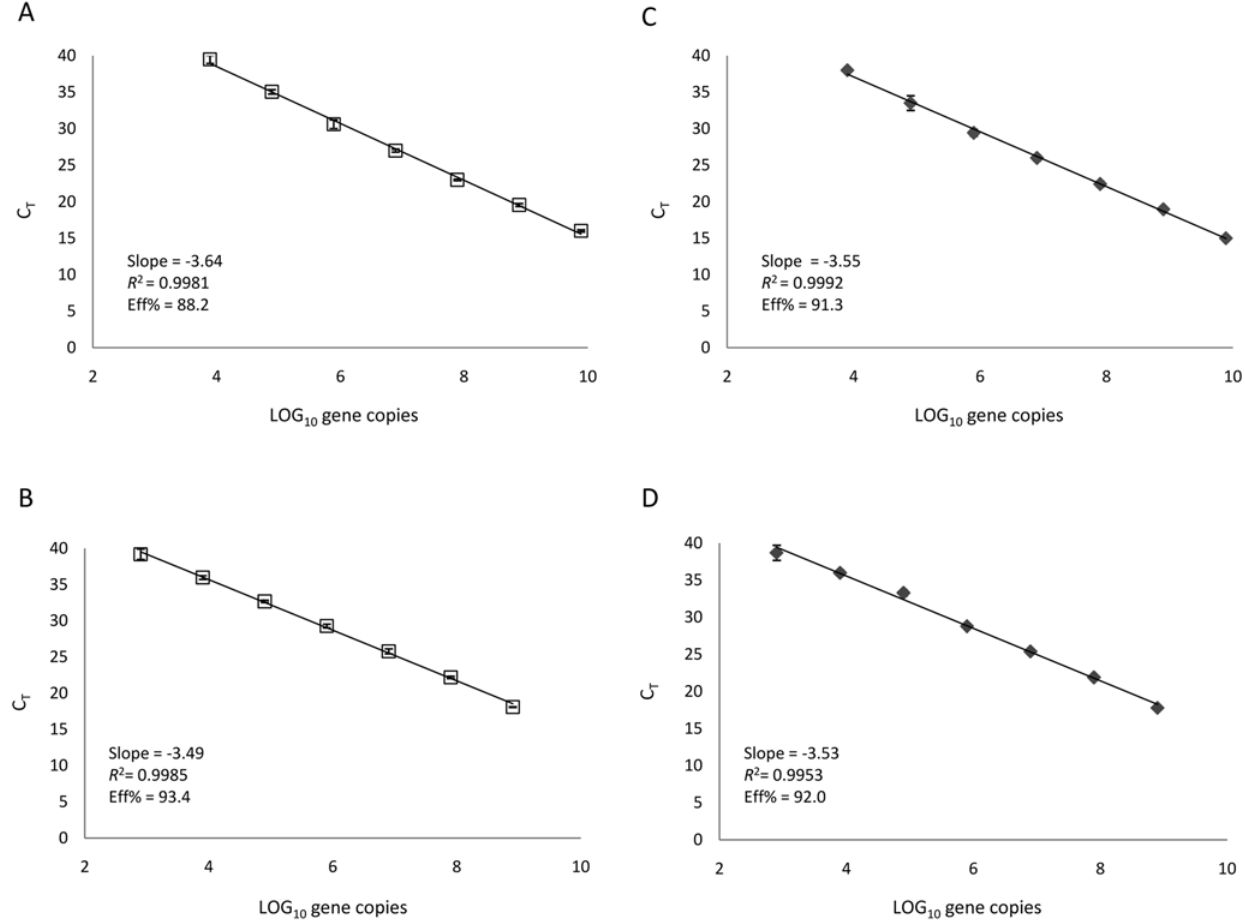
Figure 3. Sensitivity of ssqPCR assays using SYBR Green H or TaqMan H . Serial dilutions of ONNV ( 2 ) strand cDNAs quantified with tagged ssqPCR assays using SYBR Green H (A) or TaqMan H (B). Serial dilutions of ONNV ( + ) strand cDNAs quantified with tagged ssqPCR assays using SYBR Green H (C) or TaqMan H (D).